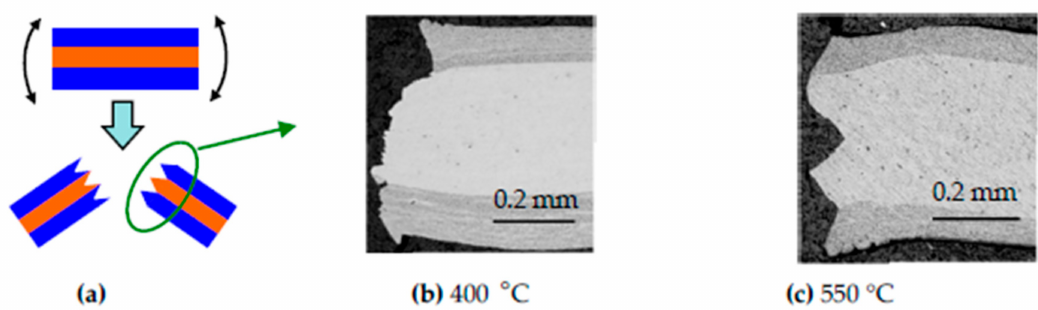
Figure 6. Schematic illustration of bending-fracture test and cross-section of fractured area of the cold-rolled 1 mm-thick clad strip. ( a ) Bending-fracture test. Base strip temperature: ( b ) 400 ◦ C, ( c ) 550 ◦